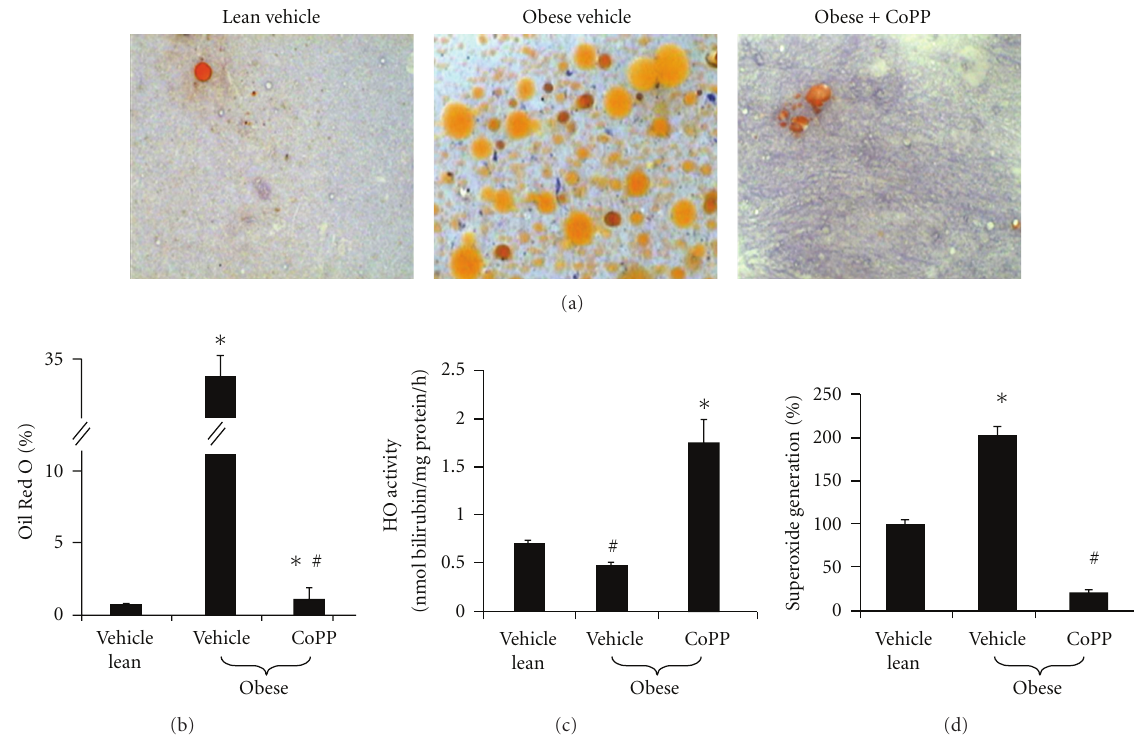
Figure 3: Evaluation of lipid content measured as percentage of Oil Red O staining. (a) Representative photographs demonstrating an increase in lipid droplets in the bone marrow of obese mice compared to lean mice and obese mice treated with CoPP. (b) Quantitative analysis of bone marrow lipid content showing a significant increase in Oil Red O staining in the obese vehicle. Please note bars on the graphs represent the mean ± SEM of three independent experiments; ∗ P < 0 . 05 versus vehicle-treated lean mice; # P < 0 . 05 versus vehicle- treated ob mice. (c) HO activity of bone marrow cells showing an increase in HO activity in both lean mice and obese mice treated with CoPP when compared to obese mice not receiving treatment. Please note bars on the graphs represent the mean ± SEM of four independent experiments; # P < 0 . 05 versus vehicle-treated lean mice; ∗ P < 0 . 01 versus vehicle-treated ob mice. (d) Superoxide generation in bone marrow cells is shown to be increased in obese mice and is lowest in the mice treated with CoPP implying an antioxidant e ff ect of HO. Please note bars on the graphs represent the mean ± SEM of four independent experiments; ∗ P < 0 . 05 obese versus vehicle lean; # P < 0 . 001 versus vehicle-treated